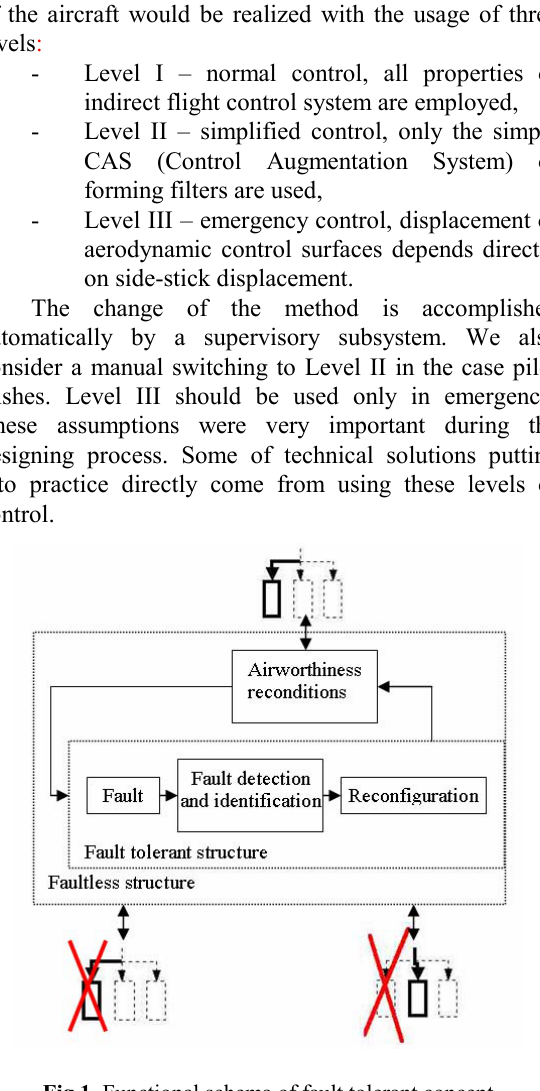
Fig 1. Functional schema of fault tolerant